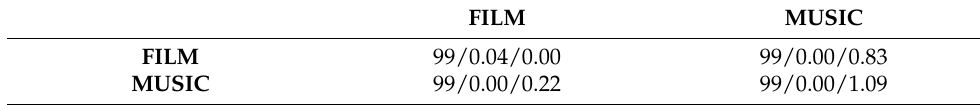
Table 7. ACC, FAR and FRR for the 1st CNN model (%).